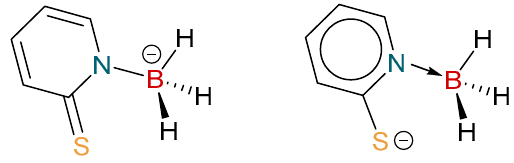
Figure 4. Two bonding descriptions for the [H 3 B(mp)] − .